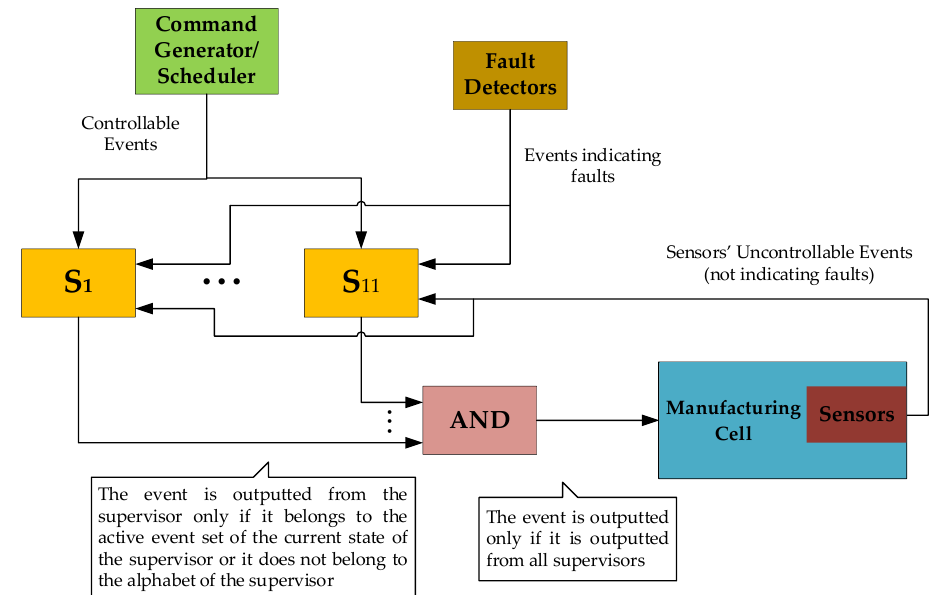
Figure 11. Operational flow chart of the supervisory control scheme.